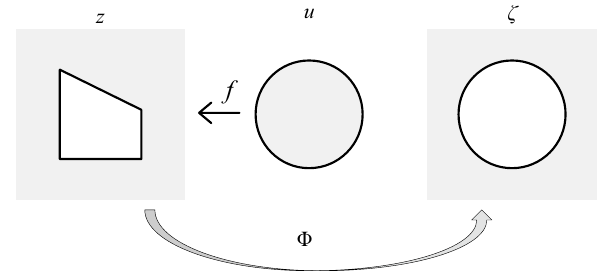
Figure 4. Mapping